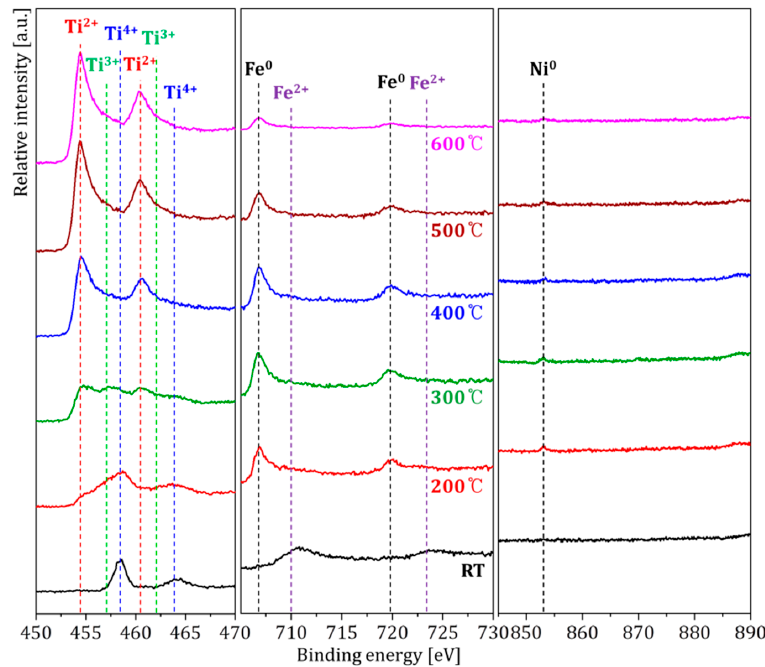
Figure 5. In situ heating X-ray photoelectron spectroscopy (XPS) of the TiFe 0.9 Ni 0.1 surface observed from room temperature (RT) to 600 °C.